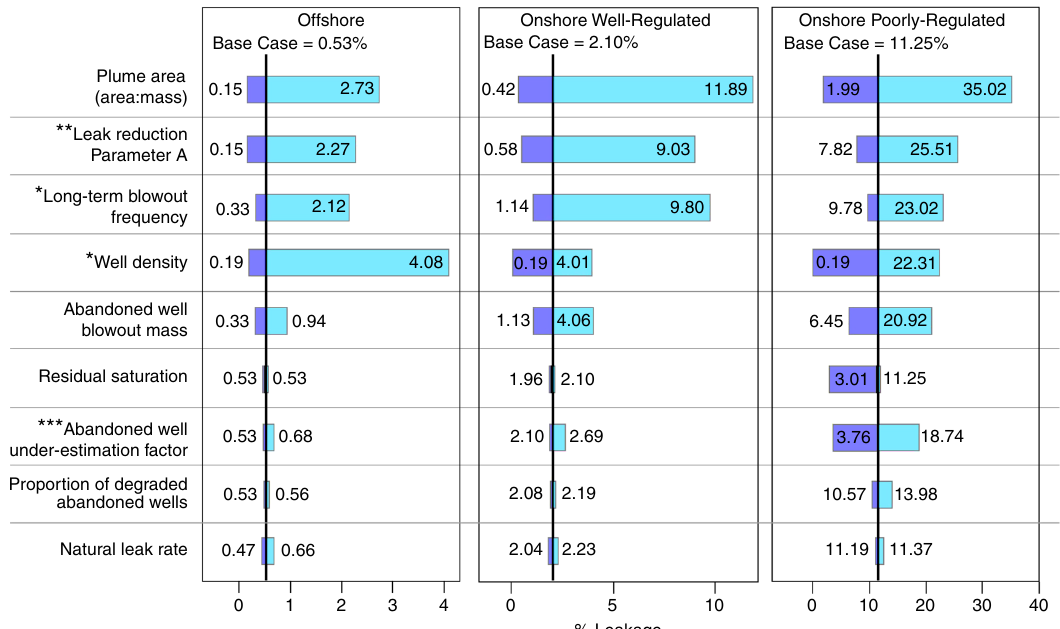
Fig. 5 Sensitivity tests of the input parameters. The tornado diagrams for the three Scenarios show the impact on leakage of changing the parameters listed. The graphs show cumulative leakage of CO 2 as a percentage of the total injected. Each parameter was assessed in turn by varying it between its maximum and minimum values, with all the other parameters held at their base case values. The parameters shown are those that have a signi fi cant impact on the computed results (a relative difference of at least 5% between the base case and sensitivity test results). Values listed are % leakage results at 10,000 years. Maximum and minimum values were de fi ned as either two standard deviations from the mean, or: *used minimum and maximum values varying between 0 and 5 wells km − 2 ; **minimum and maximum values as de fi ned in the Methods Section ***Varied between 1 and 1.1 for the well- regulated scenarios and from 1.1 to 2.0 for the Poorly-Regulated Scenario